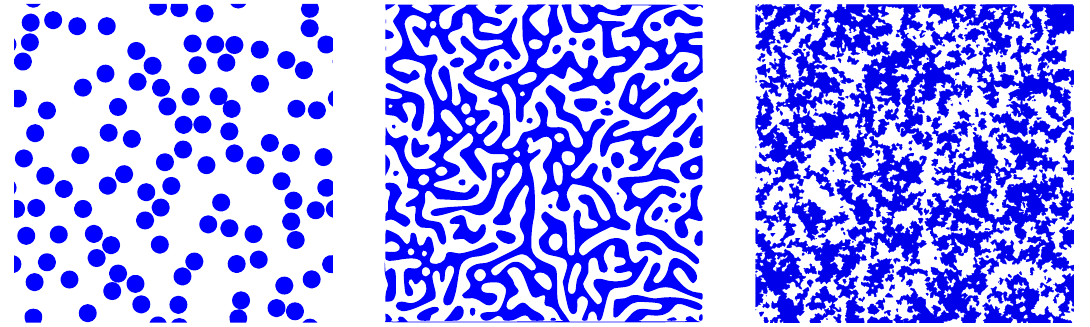
FIG. 1. Left panel: The preponderance of previous theoretical treatments of the effective dynamic dielectric constant are local in nature and restricted to dispersions of well-defined dielectric scatterers (inclusions) in a matrix, as illustrated in the leftmost panel. In contrast to the nonlocal strong-contrast formalism presented here, earlier studies cannot treat the more general two-phase microstructures shown in the middle panel (spinodal decomposition pattern [28]) and rightmost panel (Debye random medium [29,30]), both of which have “ phase-inversion ” symmetry [11]. Our formalism can, in principle, treat two-phase media of arbitrary